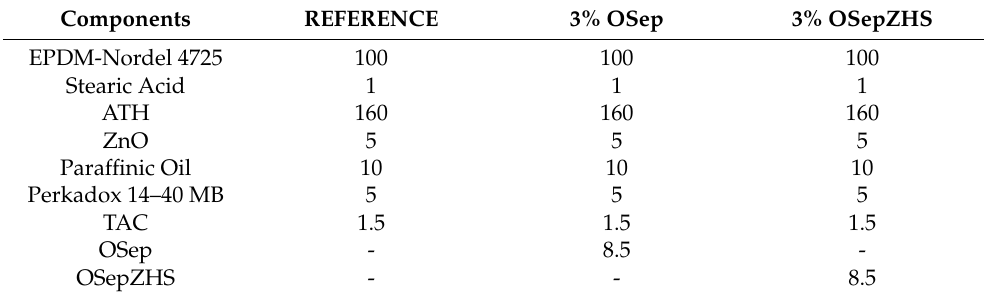
Table 1. Formulation of EPDM system for cable. The composition is shown in phr (parts per hundred rubber).